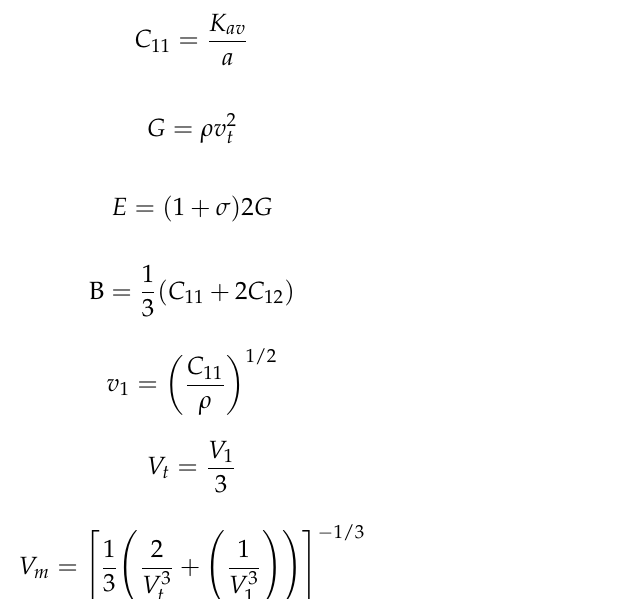
Table 4 display the values of the different elastic parameters derived using the relations (12)–(18). The values of elastic properties of Co-Cr ferrite were decreased by the addition of Dy 3+ ions. Rendering to isotropic elasticity theory, Poisson’s ratio should be in the range of − 1 to 0.5 for the materials to exhibit acceptable elastic behaviour [45,48–50]. Herein, obtained Poisson’s ratio is ~0.35 suggesting the reasonable elastic behaviour of the CoCr 0.5 Dy x Fe 1.5 − x O 4 . Elastic moduli were described by the strength of the ionic bonds; stronger bonds increase the elastic moduli, and vice versa. It is evident that replacement of Fe 3+ ions by Dy 3+ ions weakens the interatomic bonding and lowers the elastic modulus values. Debye temperature ( θ D ) was obtained using the Waldron’ relation [45]: